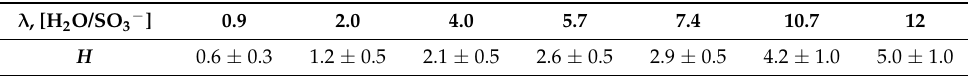
Figure 12. Temperature dependence of water proton chemical shifts in the Li + , Na + , and Cs + ionic forms of Nafion membranes at various relative humidity where δ H2O is the bulk water chemical shift δ H2O = 4.30 ppm relatively TMS, at 20 ◦ C: Li + ionic form: (1) λ = 0.9, (2) λ = 2.0, (3) λ = 4.0, (4) λ = 5.7, (5) λ = 7.4, (6) λ = 10.7, (7) λ = 12; (8) Na + ionic form, λ = 10; (9) Cs + ionic form, λ = 4; (10) bulk water; λ is amount of water molecules per sulfonated group. Reprinted with permission from [109]. Copyright 2021 Elsevier. Table 4. Hydration numbers h of Li + cation in lithium form of Nafion 117 membrane at different water contents λ